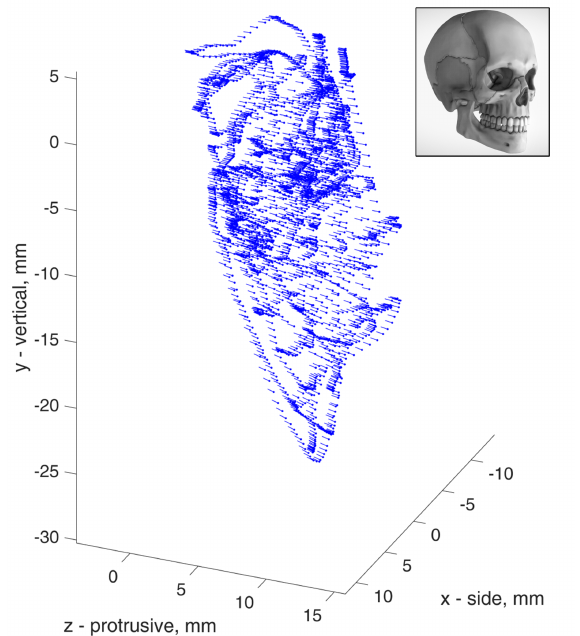
Figure 9. Cloud of recorded 6–DOF (Degree of freedom) reference jaw positions with rotational angles, depicted as vector arrows. The skull image [11] is provided as the orientation reference. Points representing rotation-to-translation dependencies were plotted from every reference data point and compared to calculations based on the proposed equations. The jaw parameters of the volunteer were measured by hand using a ruler and were equal to L = 45 mm, H = 33 mm, W L = 64 mm, and W R = 16 mm. The comparisons are presented in Figures 10 and 11.